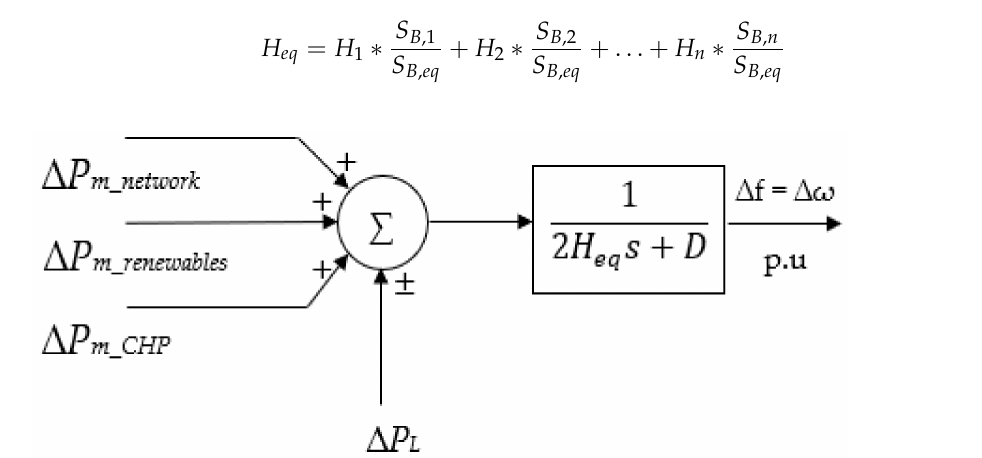
Figure 3. A simplified model for frequency control, through the analysis of equivalent inertia constant and load damping constant.